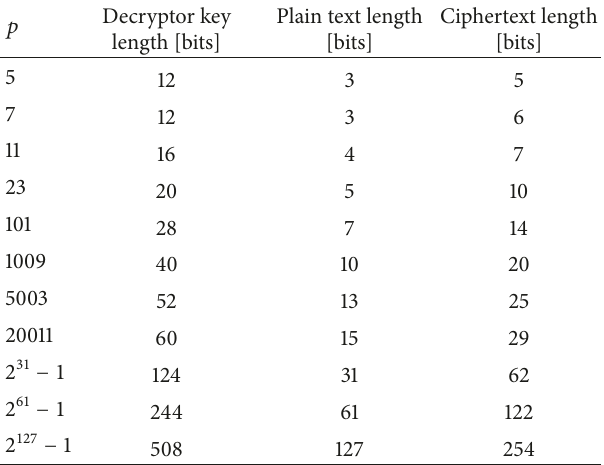
Table 1: Parameter examples for SymmetricBlind